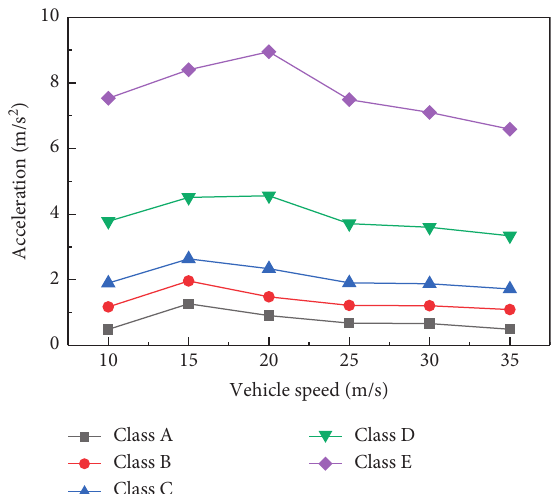
Figure 9: Maximum response of bridge acceleration via various vehicle and roughness classes.